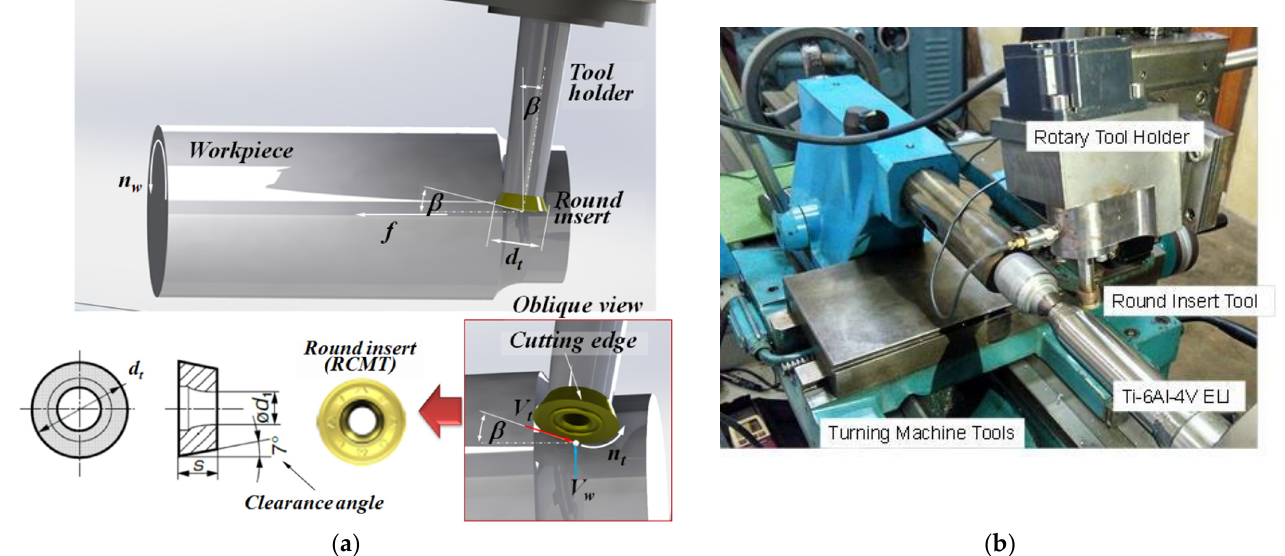
Figure 4. ( a ) Modular rotary tool holder system and cutting parameters of turning with the ADRT; ( b ) experimental set-up.